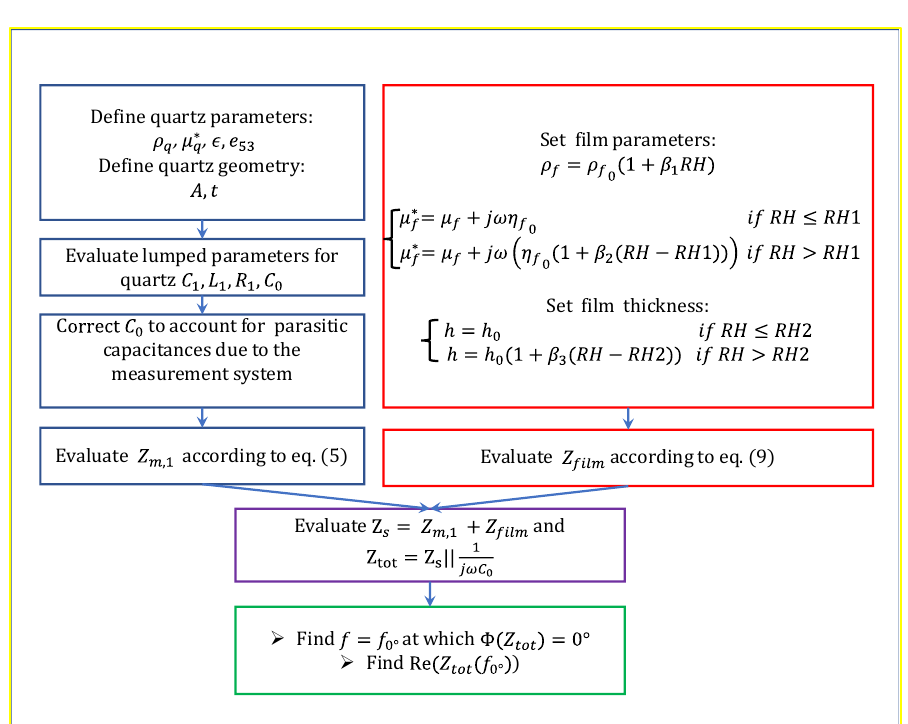
Figure 7. Block diagram of the model implementation. RH1 and RH2 are the RH level taken as thresholds for considering capillary condensation and film swelling respectively, β 1 , β 2 and β 3 are proportionality coefficients.